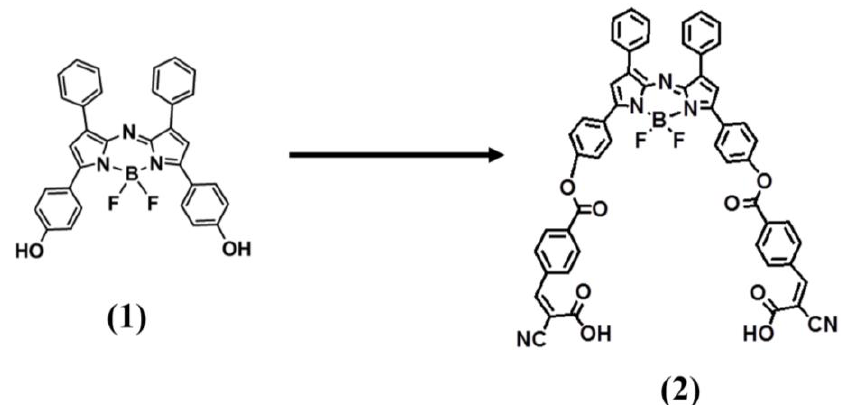
Figure 1. Chemical Structures and synthesis routes of ADP(CA) 2 .